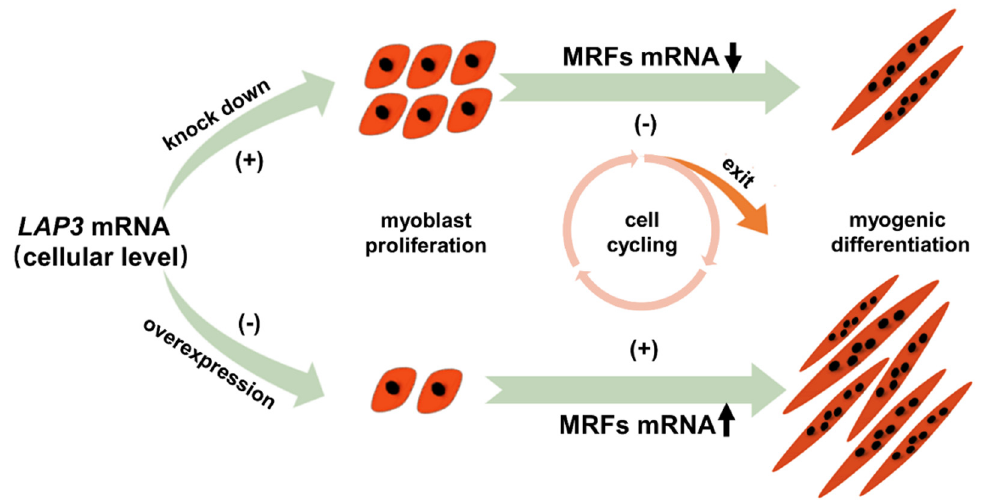
Figure 7. Proliferation and differentiation model of embryonic myoblasts after knockdown and overexpression of LAP3 mRNA. ( − ) means inhibition; and (+) means promotion. The upper layer represented that knocking down of LAP3 mRNA promoted myoblast proliferation, but down-regulated the expression levels of MRFs and inhibited myogenic differentiation of embryonic myoblasts; the lower layer represented that overexpression of LAP3 mRNA inhibited myoblast proliferation, but up-regulated the expression levels of MRFs and promoted myogenic differentiation of embryonic myoblasts.